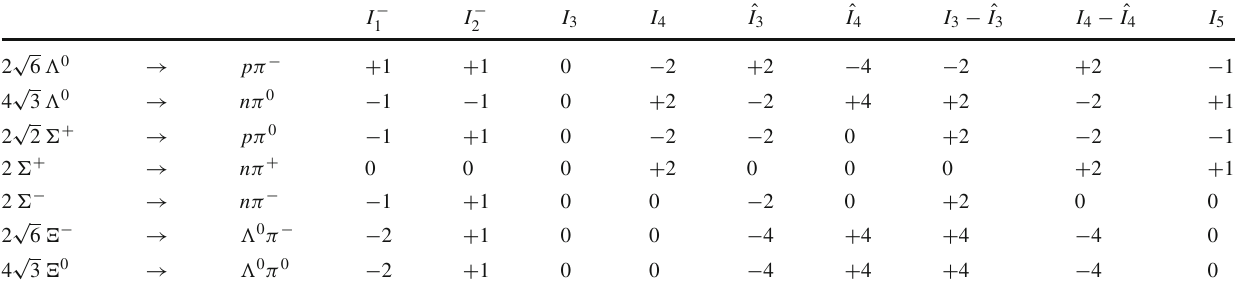
Table 13 Values of the seven SU(3) tensor invariants for the nonleptonic hyperon decays induced by the transitions ( s → u ; u → d